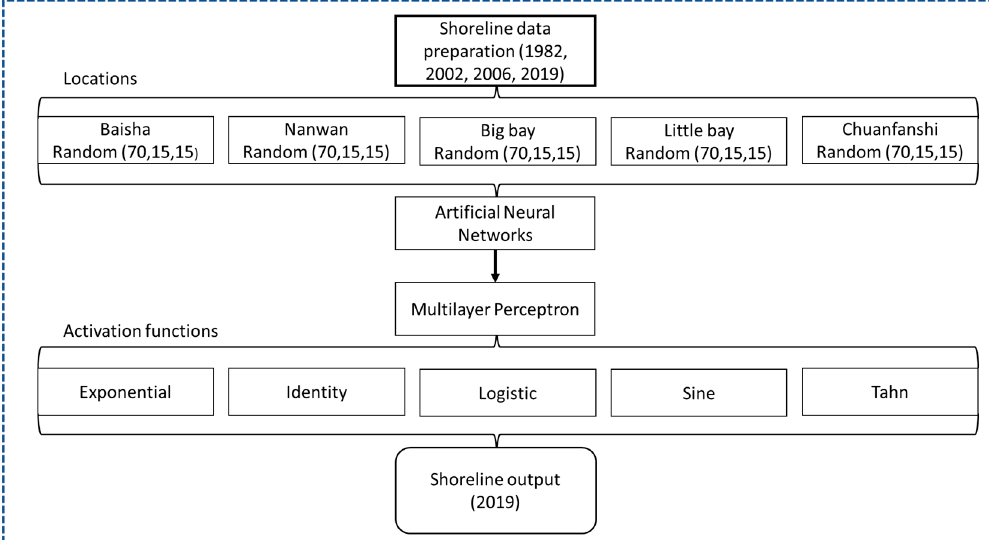
Figure 2. Flow chart of the study.